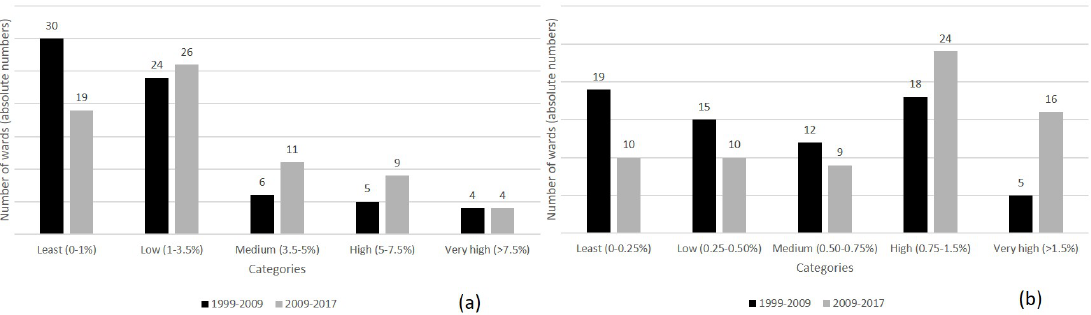
Figure 7. Changes in category (number of wards (absolute numbers)) of ( a ) U er and ( b ) U ei for T 1 and T 2 .